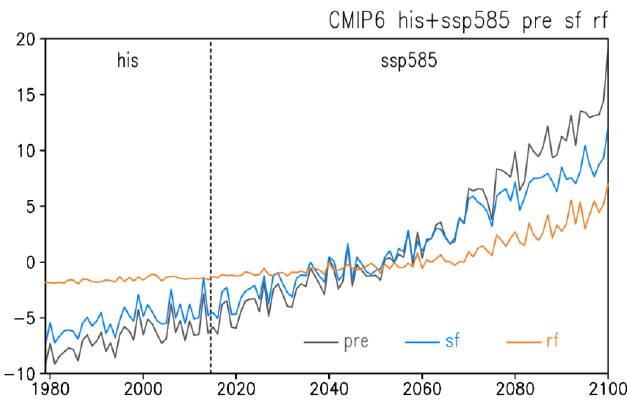
Figure 9. Time series of multi-model ensemble area-mean NDJF precipitation (grey line, mm month −1 ), snowfall (blue line, mm month −1 ), and rainfall (orange line, mm month −1 ) anomalies